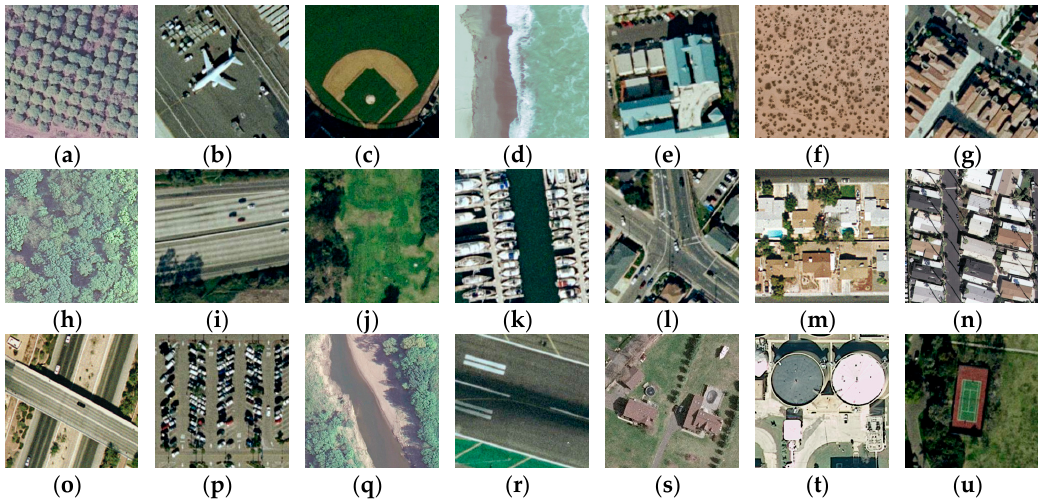
Figure 8. One example image for each class of the UC Merced Land Use Dataset: ( a ) Agricultural; ( b ) Airplane; ( c ) Baseball diamond; ( d ) Beach; ( e ) Buildings; ( f ) Chaparral; ( g ) Dense residential; ( h ) Forest; ( i ) Freeway; ( j ) Golf course; ( k ) Harbor; ( l ) Intersection; ( m ) Medium residential; ( n ) Mobile home park; ( o ) Overpass; ( p ) Parking lot; ( q ) River; ( r ) Runway; ( s ) Sparse residential; ( t ) Storage tanks; and ( u ) Tennis court.